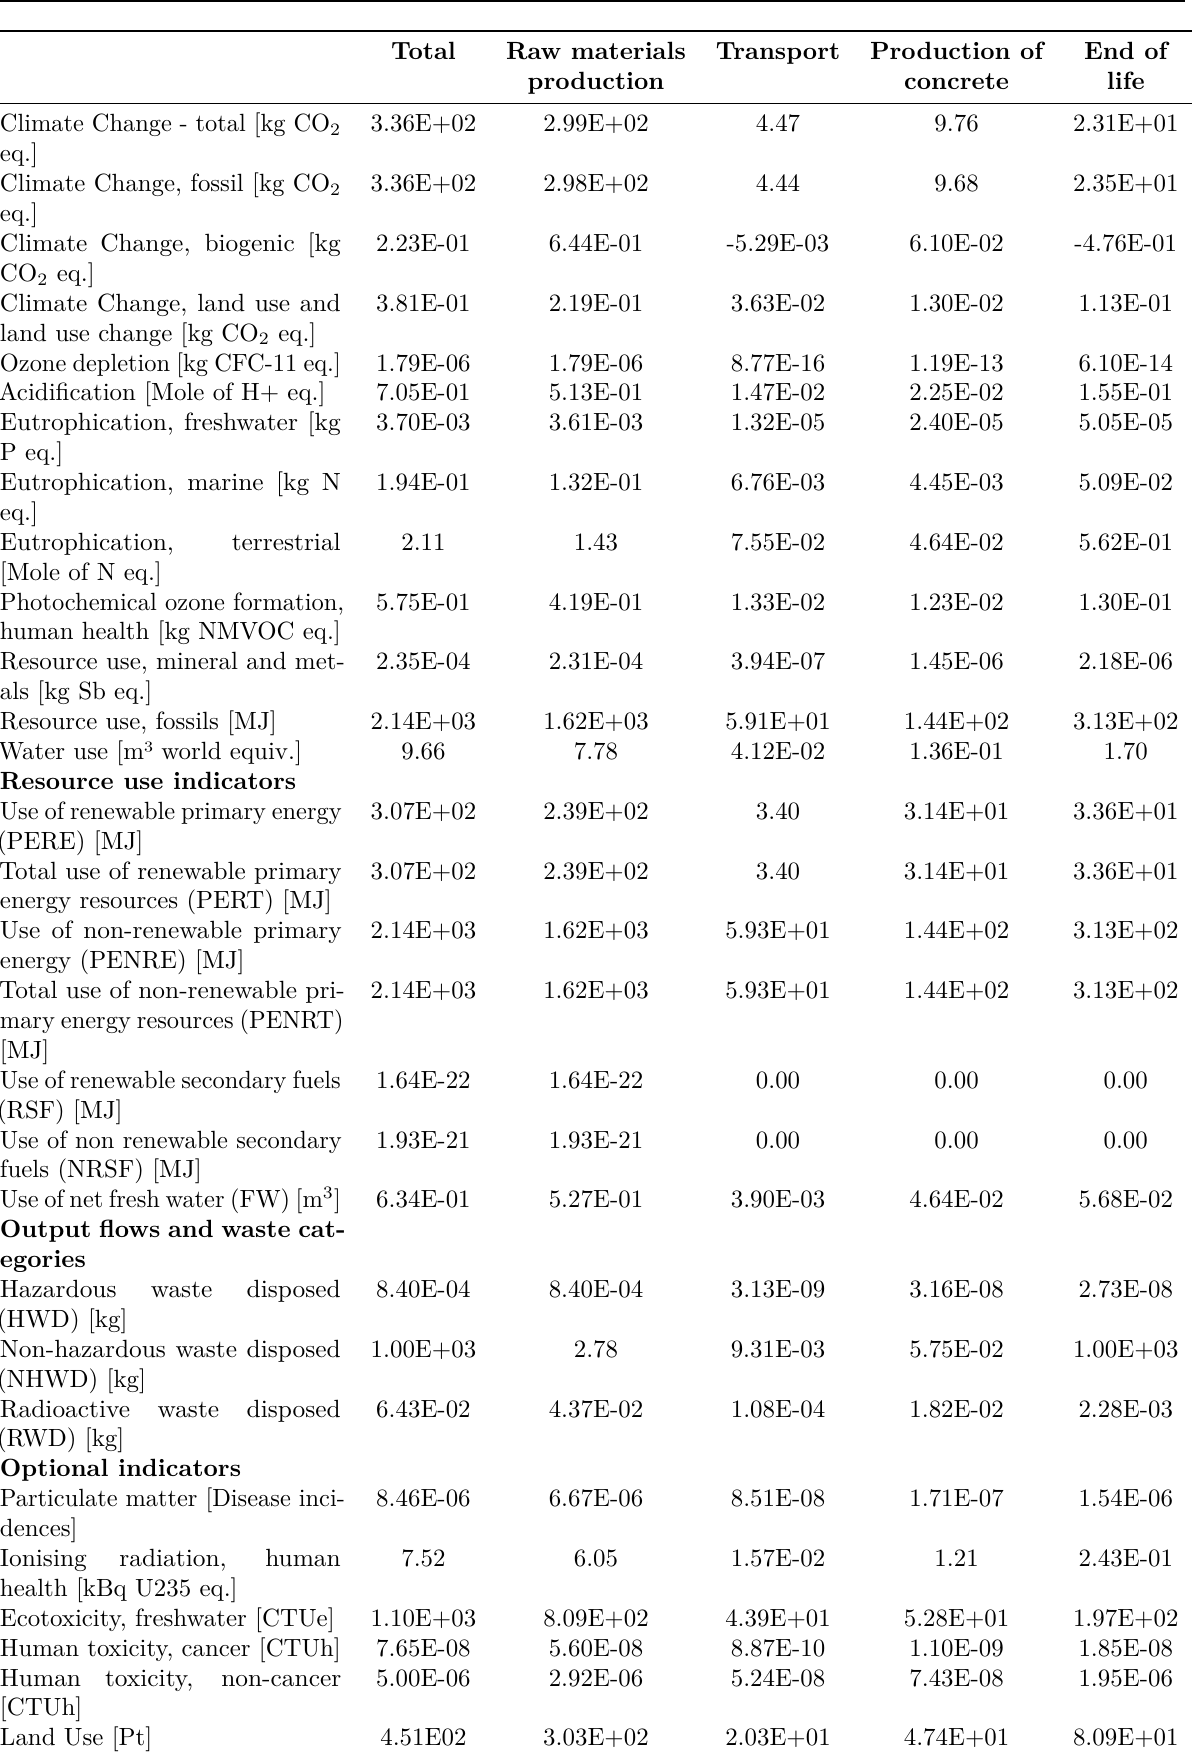
Table 3. Results of environmental indicators for the life cycle of 1 t of the lightweight block according to EN 15 804 +